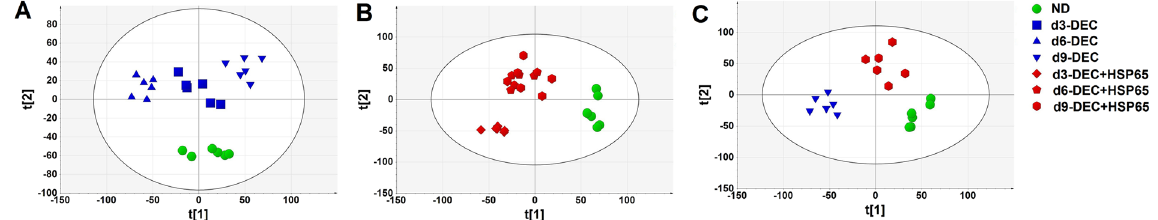
Figure 3. Multivariate analysis of extracelluar metabolites of hESC during in vitro decidualization. ( A ) Independent analysis of PLS-DA showed time dependent trend on comparing ND and d3, d6 and d9 culture media metabolomic profiles of DEC [R2X = 77.5%, R2Y = 0.990 and Q2 = 0.942]. ( B ) PLS-DA of ND and d3, d6 and d9 metabolomic profiles of DEC + HSP65 [R2X = 74.2%, R2Y = 0.978 and Q2 = 0.866] showed noticeable overlaps between d6 and d9 metabolomic profiles of DEC + HSP65. ( C ) PLS-DS revealed discrimination between metabolic profiles of ND, d9-DEC and d9-DEC + HSP65 [R2X = 83.6%, R2Y = 0.973 and Q2 = 0.827].